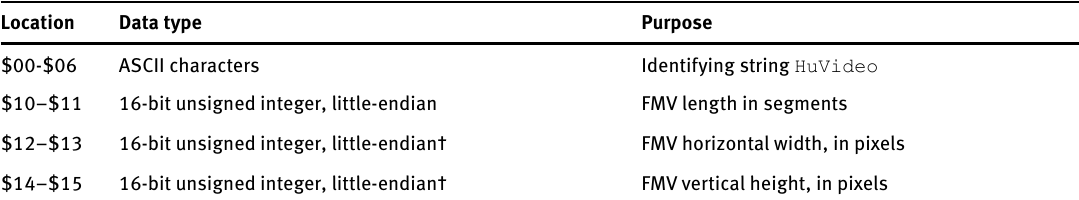
Table 6. GB (HuVideo) FMV header